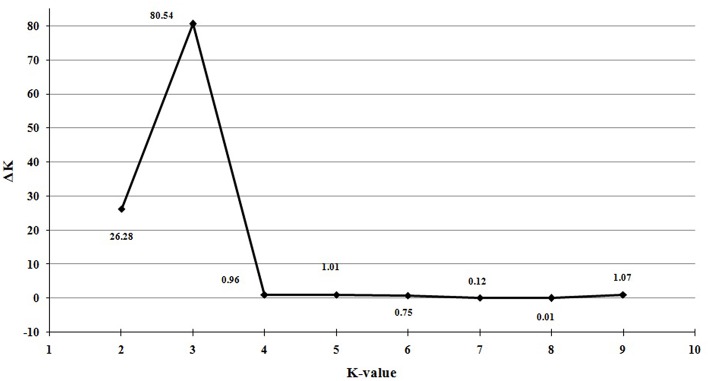
Optimal value of K determined by delta K (△K).